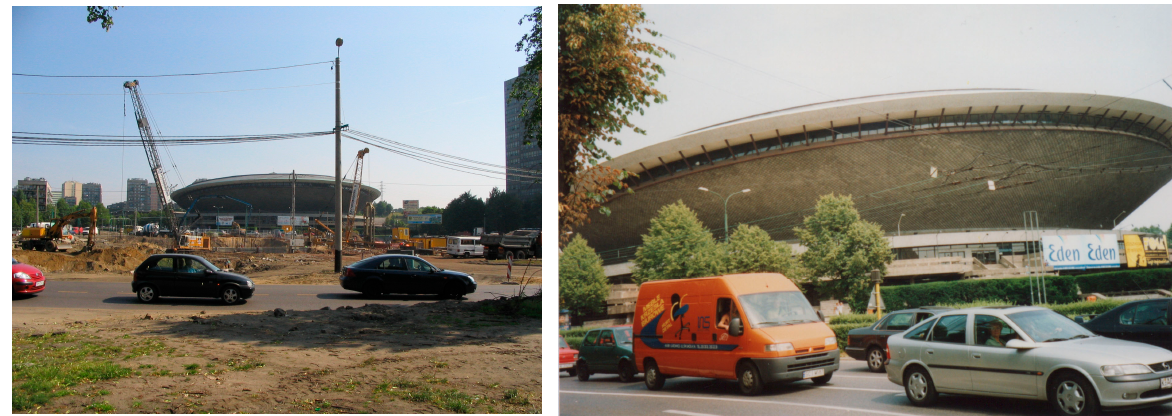
Figure 8. Objects within the impact range: sports and entertainment hall “Spodek” (Saucer).